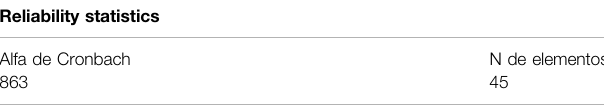
TABLE 3 | Cronbach ’ s Alpha test results for the pilot